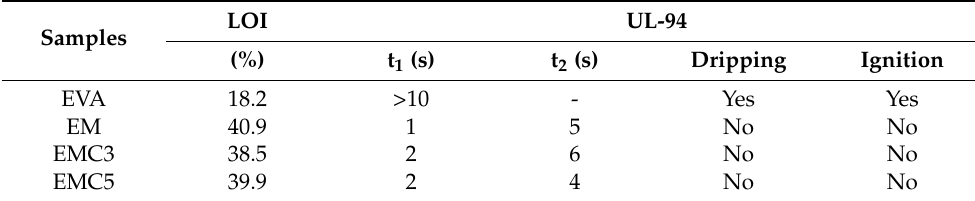
Table 6. LOI and UL-94 Results of the composites.